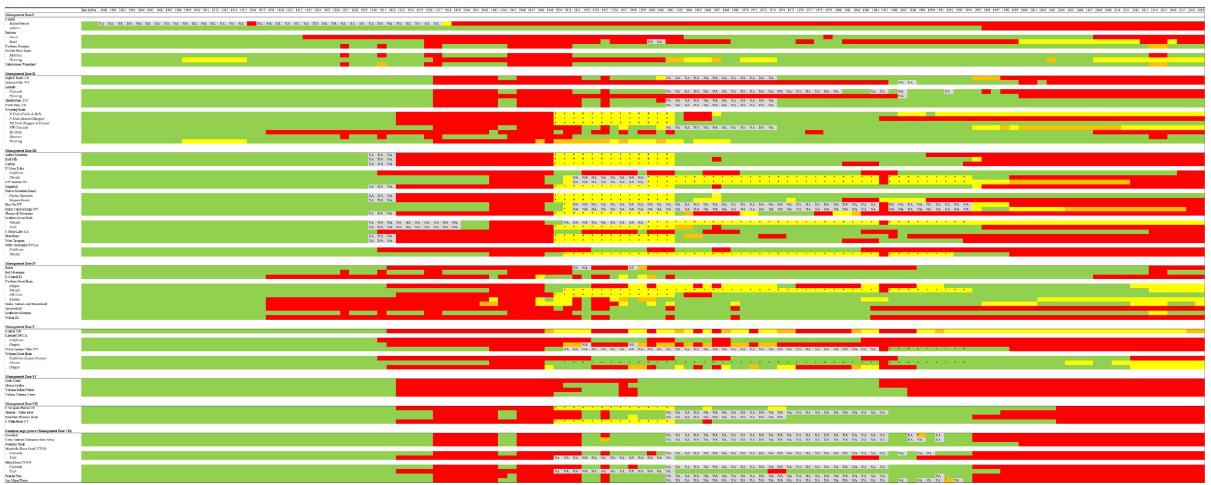
Fig 3. Timeline depicting the harvest history of sage-grouse from 1870s–2019 stratified by sage-grouse Management Zone and greater and Gunnison sage-grouse populations. Information obtained from state and provincial management agencies and 14,35,46,47,48,49,50,51,52,53,54. All populations that crossed state or provincial boundaries were sub-stratified by those legal boundaries. Green depicts years when a population stratified by state was essentially fully open to hunting, yellow depicts partial closures ( > 50% open but some closure), orange depicted partial closures ( < 50% open but some legal hunting), red depicted essentially full hunting closures, and grey with NA indicates years where no data was available. This information is also available in Excel format via S1 Table.